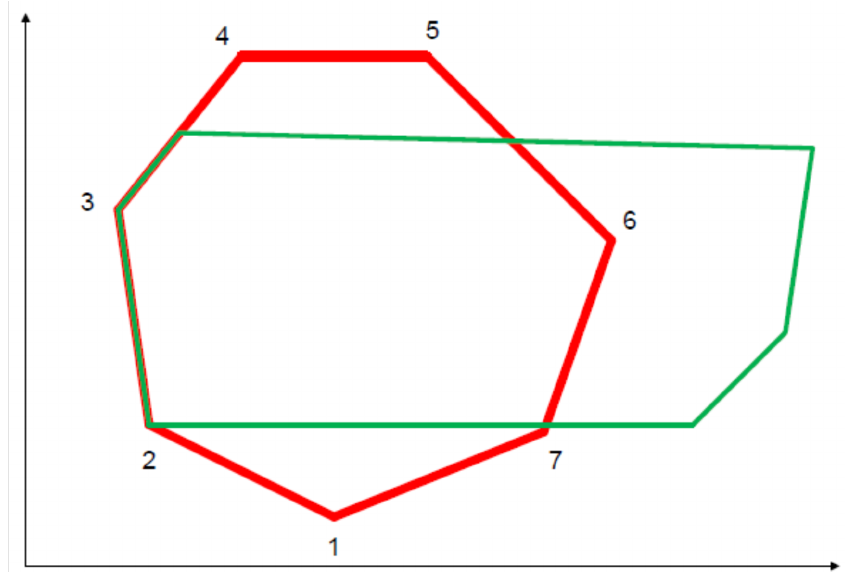
Figure 18. Initial position of processed polygons—clipping (red) and clipped (green) The numbers on the picture are the vertex identifiers of the red